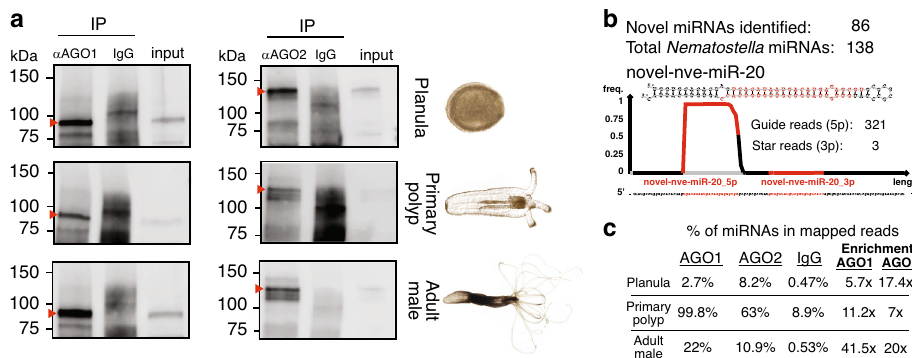
Fig. 3 Novel miRNAs identi fi cation by AGO-IP. a Western blot validations with α NveAGO1 and α NveAGO2 for the presence of NveAGO1(left, ~96 kDa) and NveAGO2 (right, ~122 kDa) following the IPs from three distinct developmental stages (bands corresponding to AGOs are indicated by red arrowheads). Each experiment was carried out twice independently. b Number of Nematostella miRNAs including novel miRNAs, and an example of a newly identi fi ed miRNA. c Average percentage of miRNA reads in sRNA libraries generated from extracts of NveAGO1, NveAGO2, and control IgG IPs. miRNA percentage was calculated from reads that mapped to the Nematostella genome. On the right is the enrichment in each of the NveAGO-IPs compared